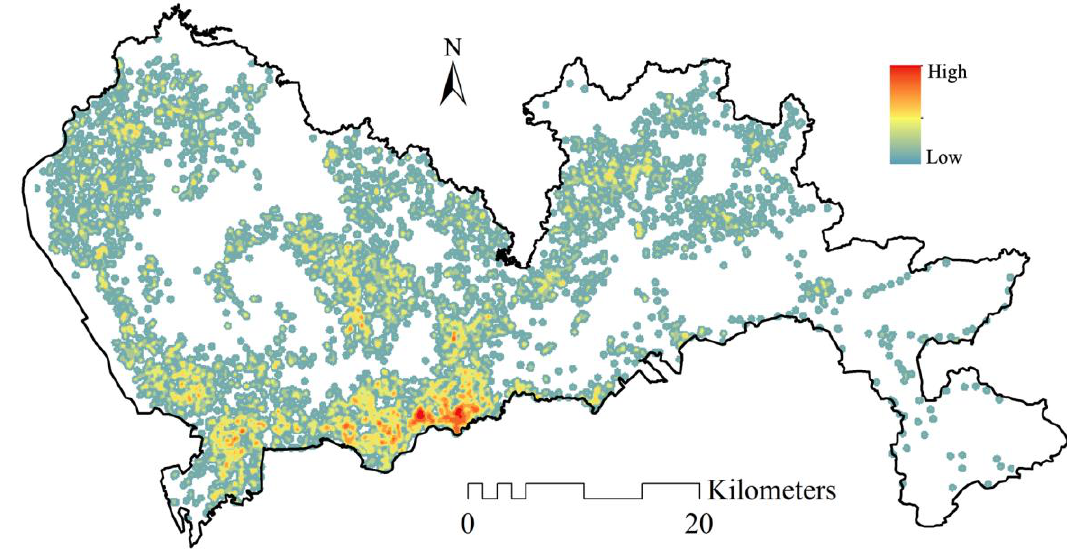
Figure 1. Spatial kernel density of the cell phone towers (CPTs).